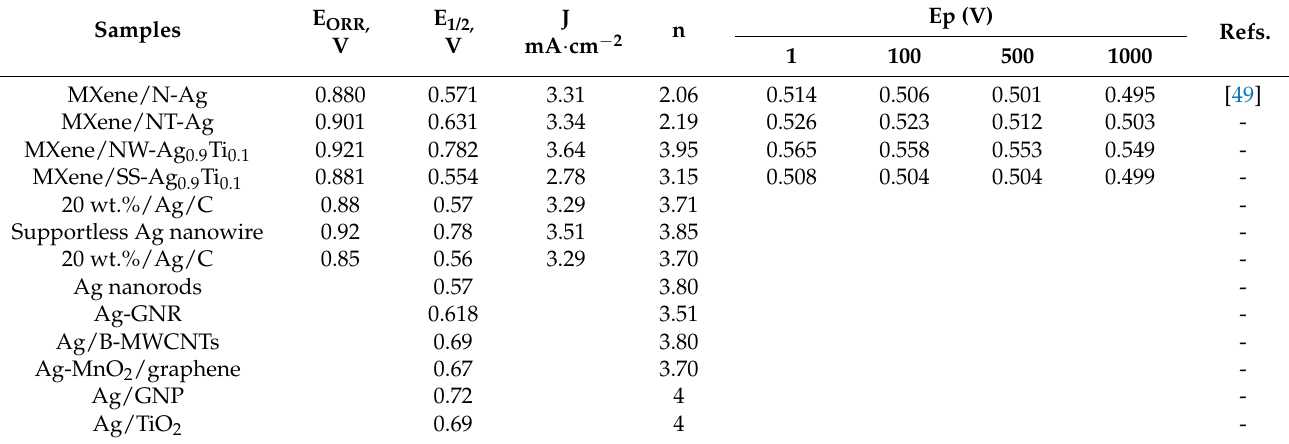
Table 2. The important parameters determined from experimental results (1600 rpm) and some related data on Ag-based catalysts. Reprinted with permission from [83]. Copyright 2016 American Chemical